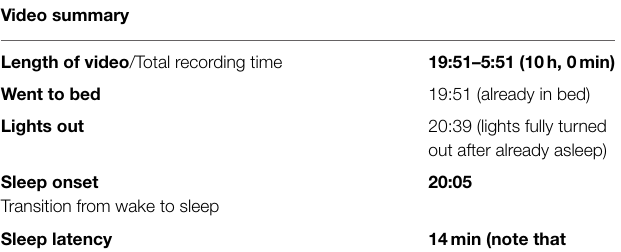
TABLE 3 | Video summary . Video